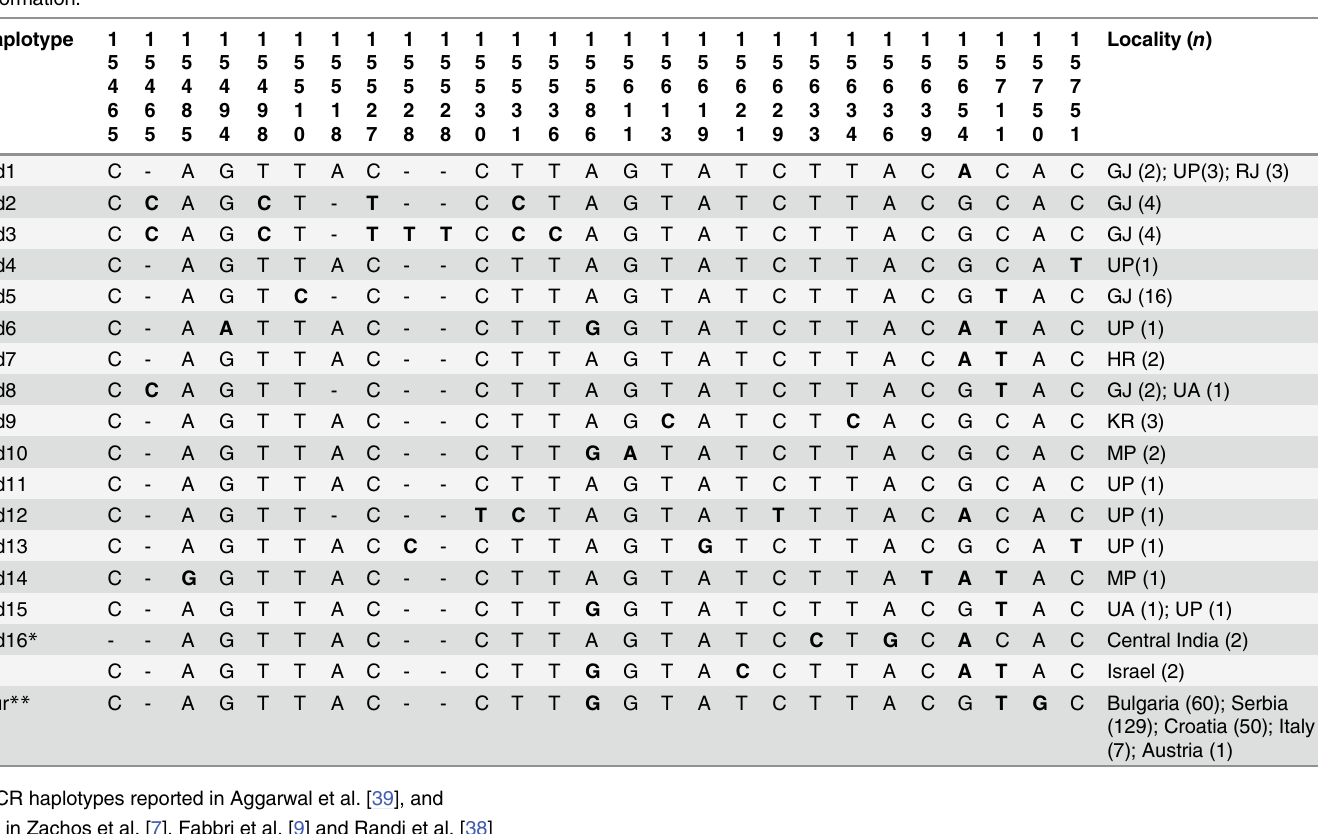
Table 1. Control Region (CR) haplotypes and variable sites in golden jackals. Numbers above each nucleotide base represent nucleotide positions rel- ative to the complete mtDNA genome of Canis lupus lupus (GenBank Accession ID — NC009686). Sampled Indian localities are Uttar Pradesh (UP), Uttara- khand (UA), Haryana (HR), Rajasthan (RJ), Gujarat (GJ), Madhya Pradesh (MP) and Karnataka (KR). Refer S1 Table for specific sample and locality information.